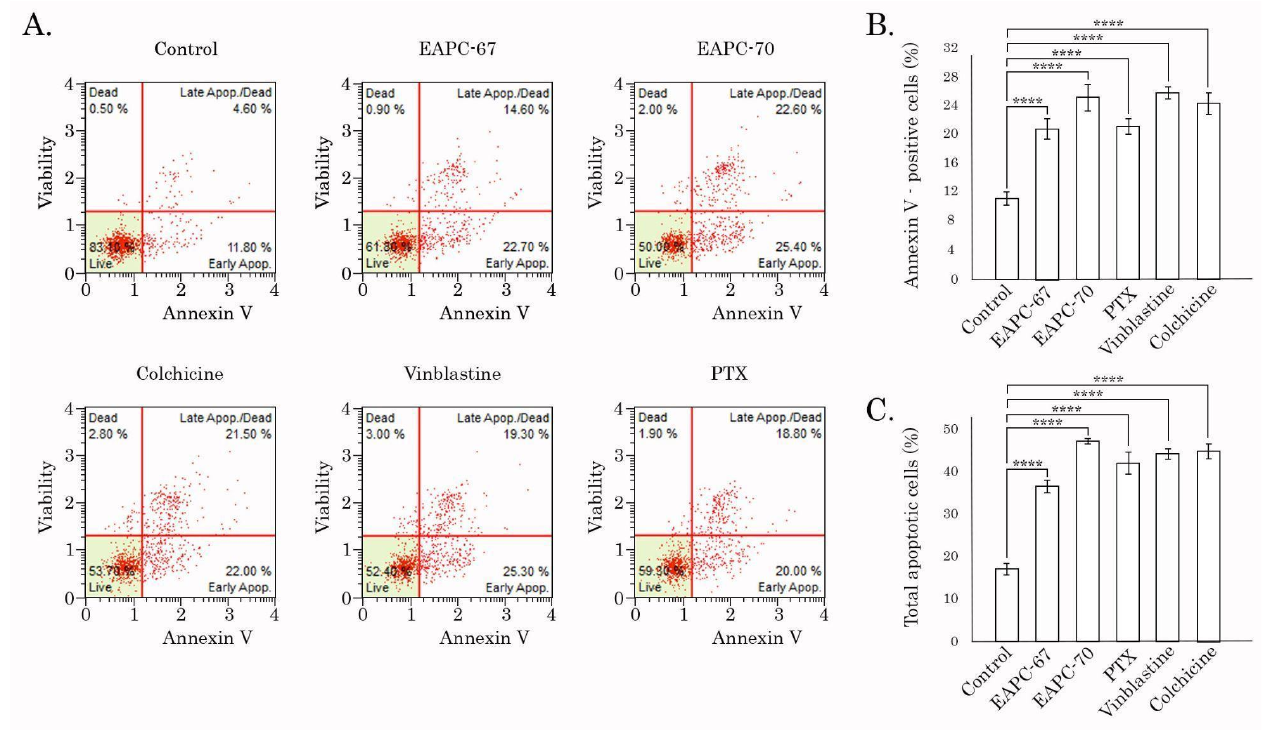
Figure 5. FACs analysis for apoptotic markers in HCC 1806 breast cancer cells treated with DMSO (control), paclitaxel, vinblastine, and colchicine (positive control), EAPC-67, and EAPC-70 for 24 h. ( A ) Representative dot plots are shown. ( B ) Quantitative analysis of the early-apoptotic cells after the treatment as indicated above. ( C ) Quantitative analysis of the total apoptotic cells after the treatment as indicated above. **** p < 0.0001.